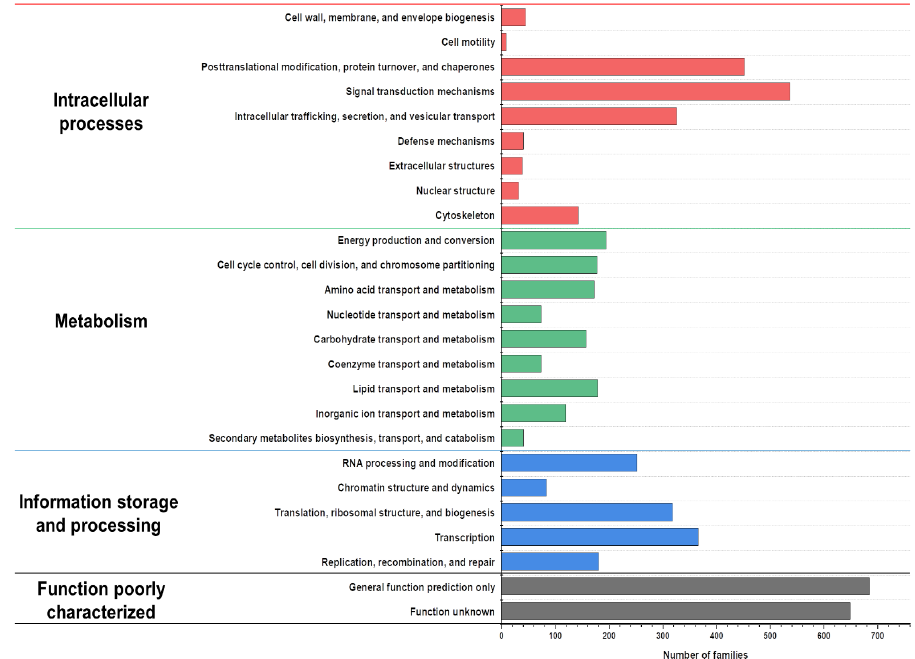
Figure 2. Eukaryotic orthologous group (KOG) distribution of predicted proteins from the A . resinae KUC3009 genome.